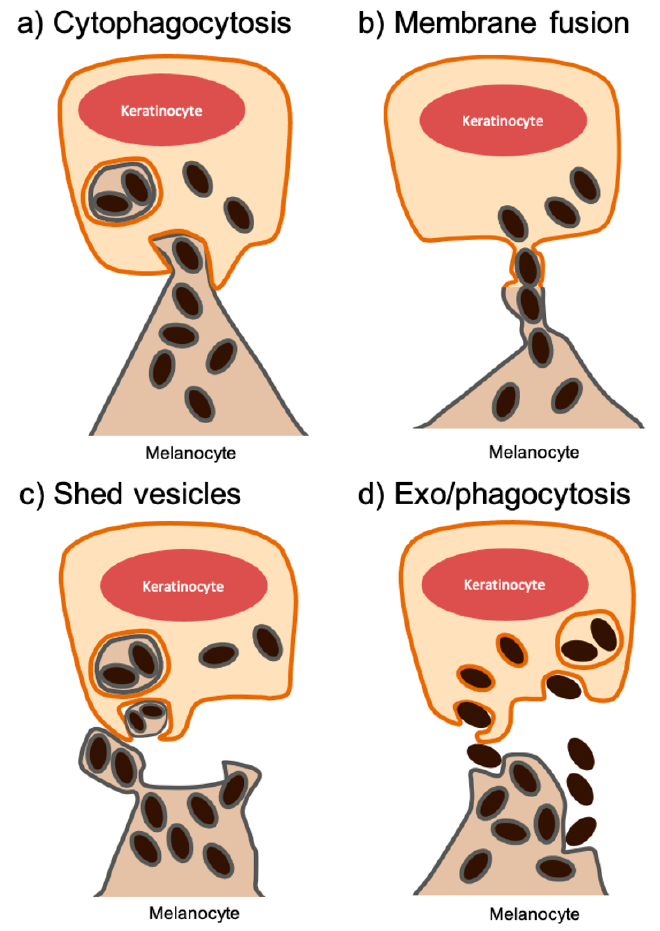
Figure 1. Proposed models for melanin transfer. ( a ) Cytophagocytosis: a melanocyte dendrite is phagocytosed, forming a phagolysosome from which melanin granules disperse through the cytoplasm of keratinocytes. ( b ) Direct membrane fusion: the plasma membranes of both cells fuse, creating a nanotube that allows the passage of melanosomes. ( c ) Shed vesicles: melanosomes are shed in vesicles from the melanocyte, which fuse with the keratinocyte plasma membrane or are phagocytosed. ( d ) Coupled exo/phagocytosis: melanin is secreted to the intercellular space through the fusion of the melanosome membrane with the melanocyte plasma membrane and is then phagocytosed by the